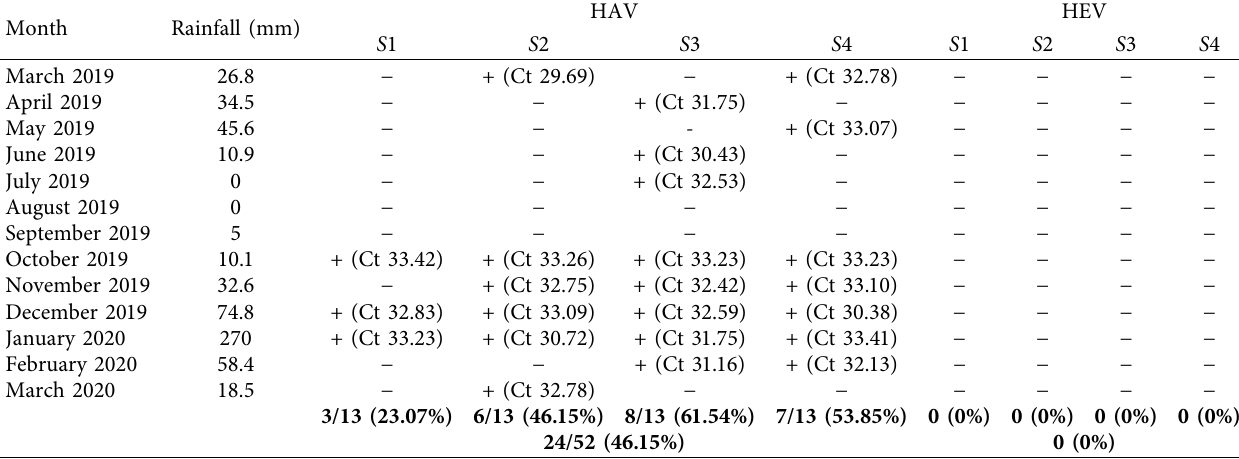
Table 2: HAV and HEV contamination rate in mussels collected at four sites at Cherrat estuary. Month Rainfall